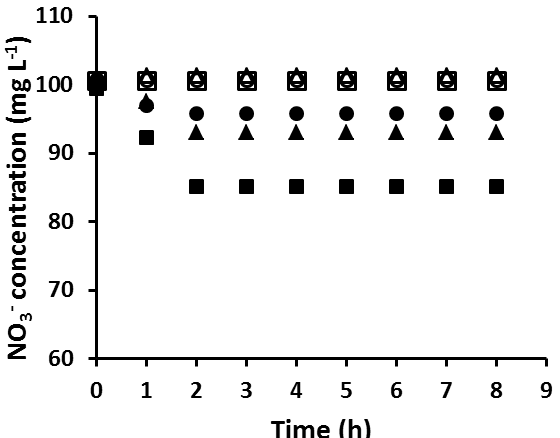
, 4.54 mg/79 h). (cid:35)